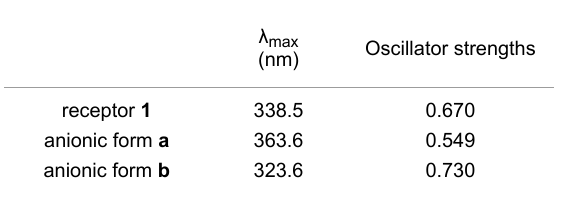
Table 1: Calculated wavelengths ( λ max ), oscillator strengths of absorp- tion spectra of receptor 1 and its anionic forms using TDDFT at level of B3LYP/6-31G(d) in CH 3 CN.